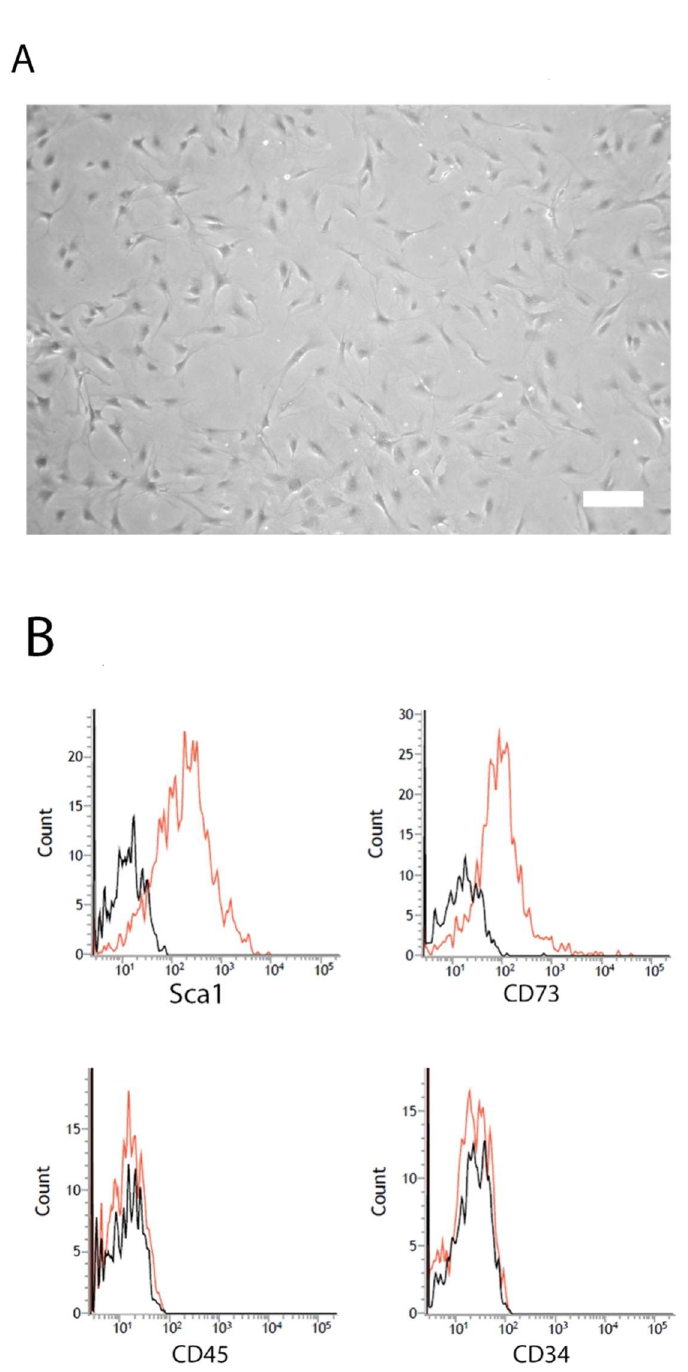
Figure 1. Cell characterization. ( A ) Characteristic phase contrast microscopy of murine adipose-derived stromal/stem cells (mASC) cultured in standard cell culture (bar: 100 µ m); ( B ) representative flow cytometric histograms (red) of the expression of characteristic markers. Black histograms show isotype controls.